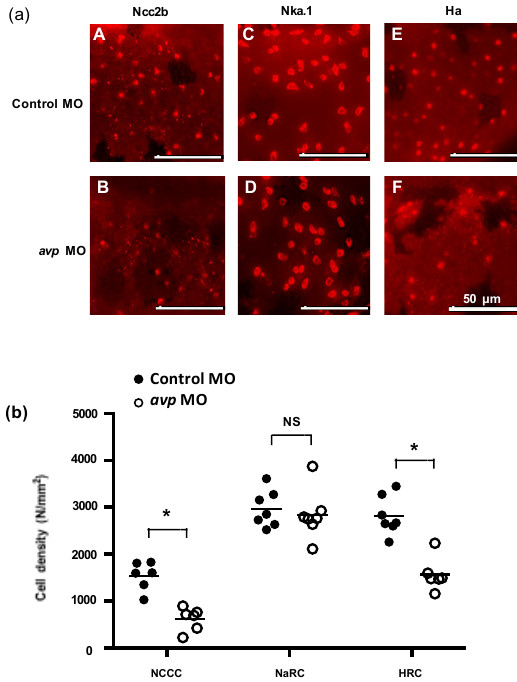
Figure 5. E ff ects of morpholino-mediated downregulation of AVP on ionocyte cell density in 3 dpf embryos. ( a ) NCC (A,B), NaR (C,D), and HR (E,F) cells were visualized by immunofluorescence labeling, using antibodies against NCC2b (A,B), NKA.1 (C,D), and HA (E,F), respectively at 3 dpf. Scale bars represent 50 µ m. Mean cell density of ionocytes ( b ) is shown as a solid line with individual values indicated by black-filled circles for control morpholino-injected larvae or white-filled circles for antisense Avp mopholino-injected larvae. Values are means ( n = 6–8). Asterisks indicate significant di ff erence from control, according to Student’s t -test, p < 0.05. NS indicates no significant di ff